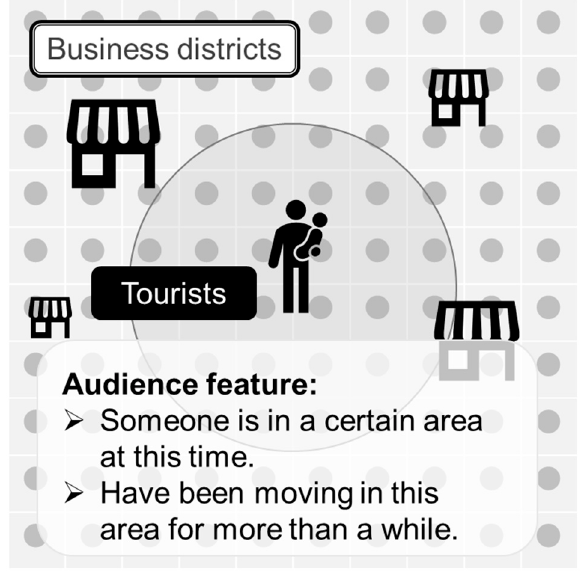
Figure 4. Audience feature in Case 4.